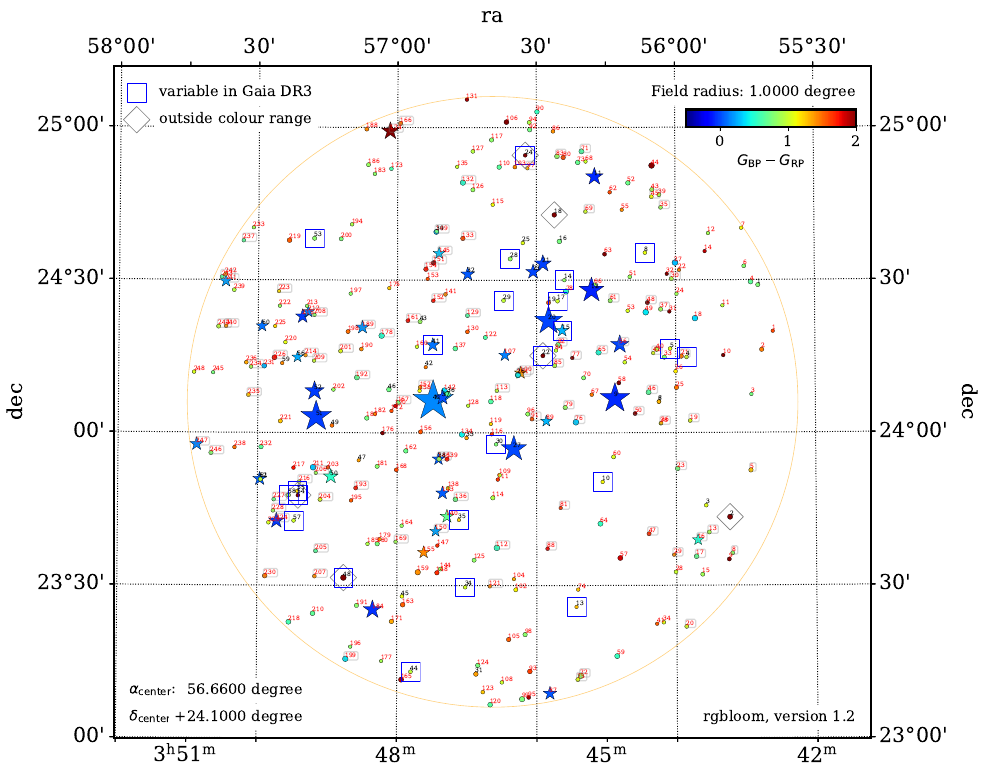
Figure 15. Example of a finding chart generated by the Python package RGBLOOM after performing a cone search centred in the Pleiades star cluster with a search radius of 1 degree. The objects in this plot are colour coded based on the Gaia G BP − G RP colour and are numbered with labels of different colours (red or black for objects belonging or not to the 200 M sample, respectively) with numbers matching the first column of the output files rgbloom_200m.csv and rgbloom_no200m.csv generated during the execution of the code. The identification number of the less reliable sources in rgbloom_- 200m.csv (those with qlflag = 1) appear within a rectangle with a light-gray colour. For sources that do not belong to the 200 M sample, and where RGB estimates correspond to the polynomial transformations from C21, which can be affected by systematic biases, the program overplots a blue square when the Gaia DR3 phot_variable_flag is set to VARIABLE and a grey diamond when the source colour is outside the − 0.5 ≤ G BP − G RP ≤ 2.0 mag